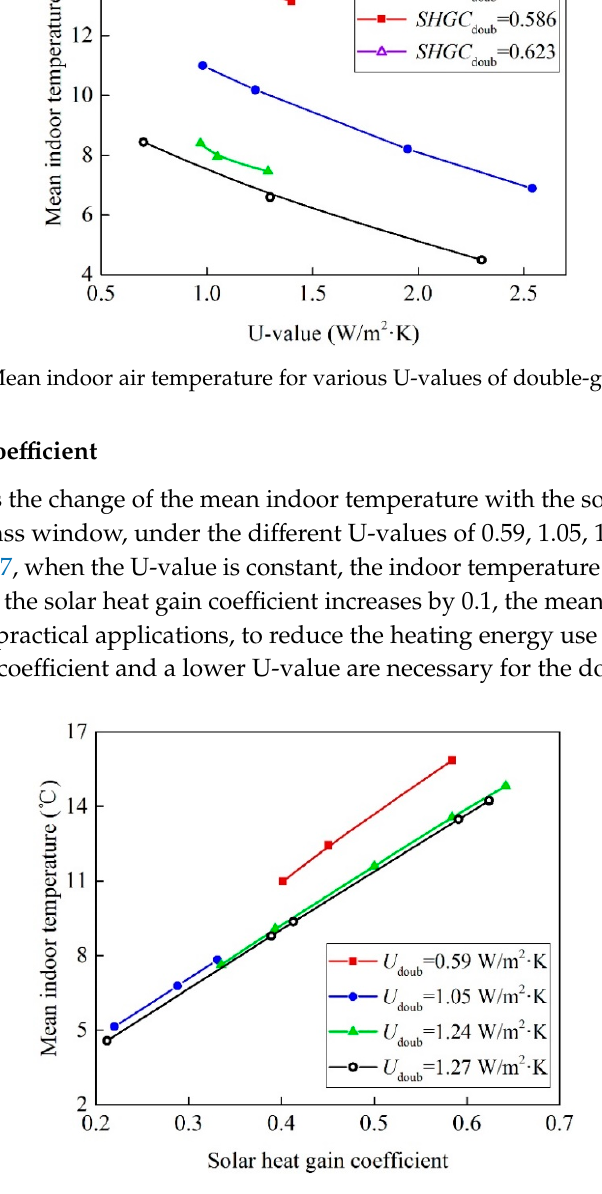
Figure 17. Mean indoor temperature under various solar heat gain coefficients.